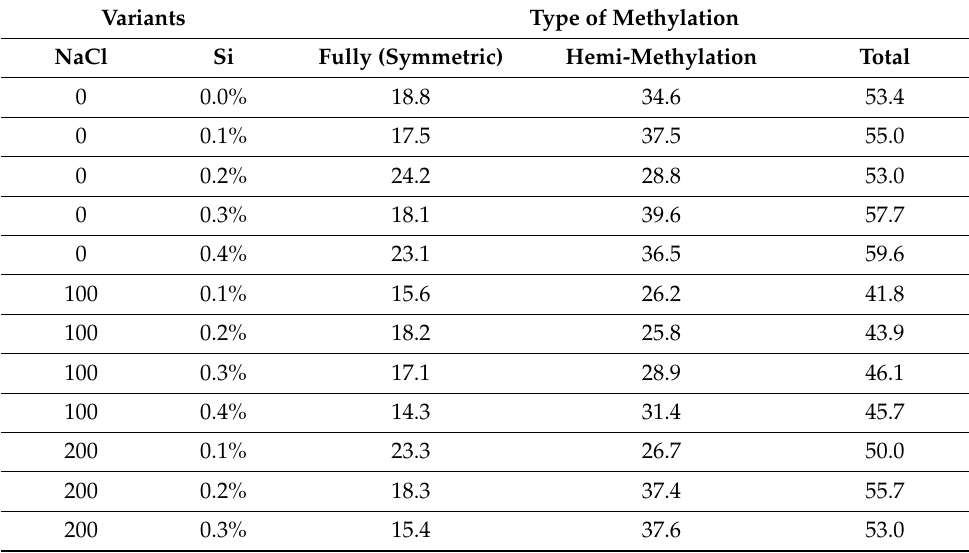
Figure 6. Comparison of representative MSAP bands (products of selective amplification of the EcoRI-AT × MspI/HpaII-ATG primer combination used). H and M refer to digestion with EcoRI + HpaII and EcoRI + MspI, respectively. Red arrows show polymorphic bands. Total percentage of DNA methylation was calculated and presented in Table 1. Table 1. Percentage scores of methylation events.